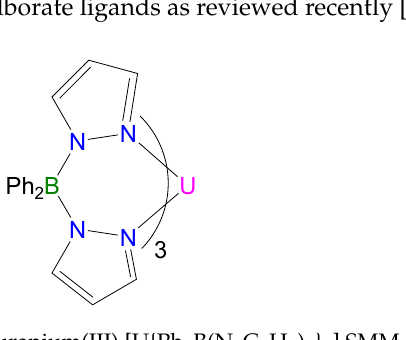
Figure 5. Structure of the uranium(III) [U{Ph 2 B(N 2 C 3 H 3 ) 2 } 3 ] SMM [127].